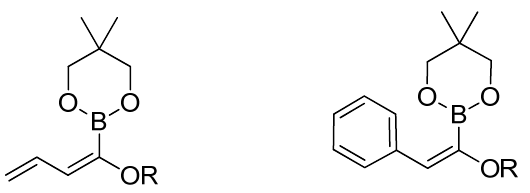
Figure 2. Alkoxydienyl and alkoxystyryl boronates.